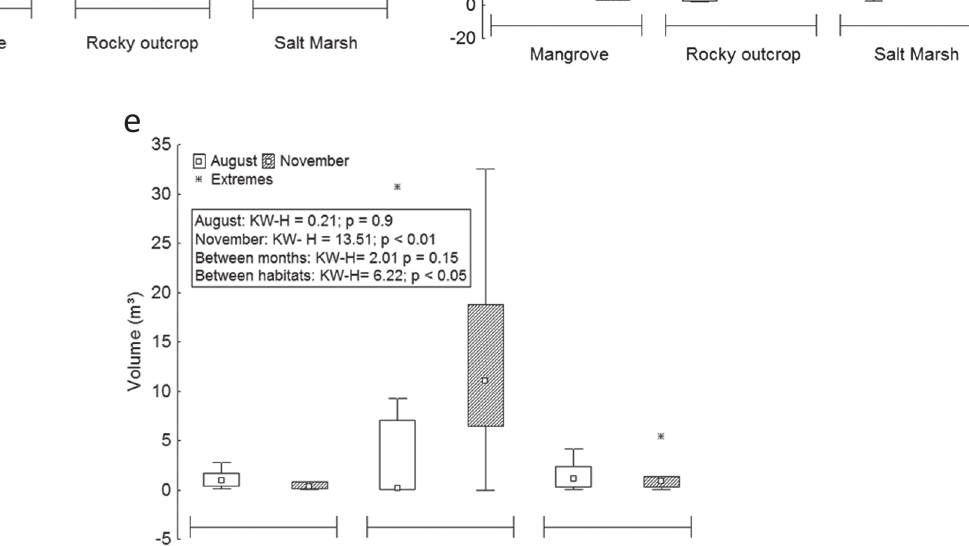
An Acad Bras Cienc (2014) 86 (1)